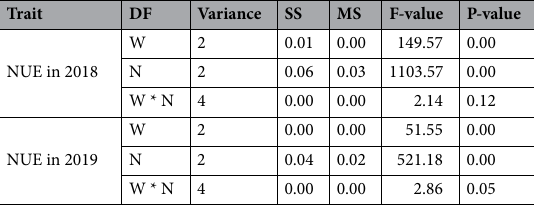
Table 6. Variance analysis of traits on the NUE of Isatis indigotica .